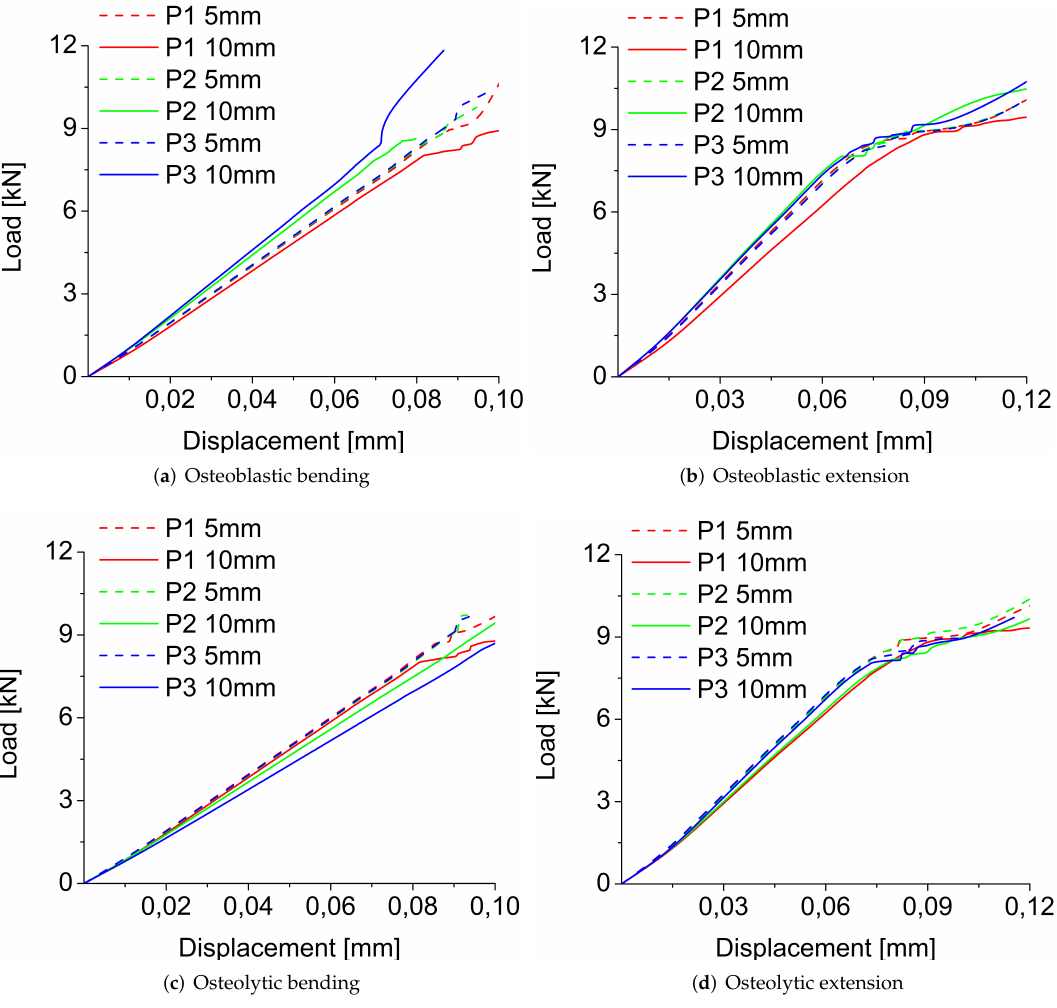
Figure 8. Load-displacement curves obtained for osteoblastic, ( a , b ); and osteolytic, ( c , d ); metastases in bending, ( a , c ); and extension, ( b , d ); loading modes using the strain-based failure criterion varying the radius and position of